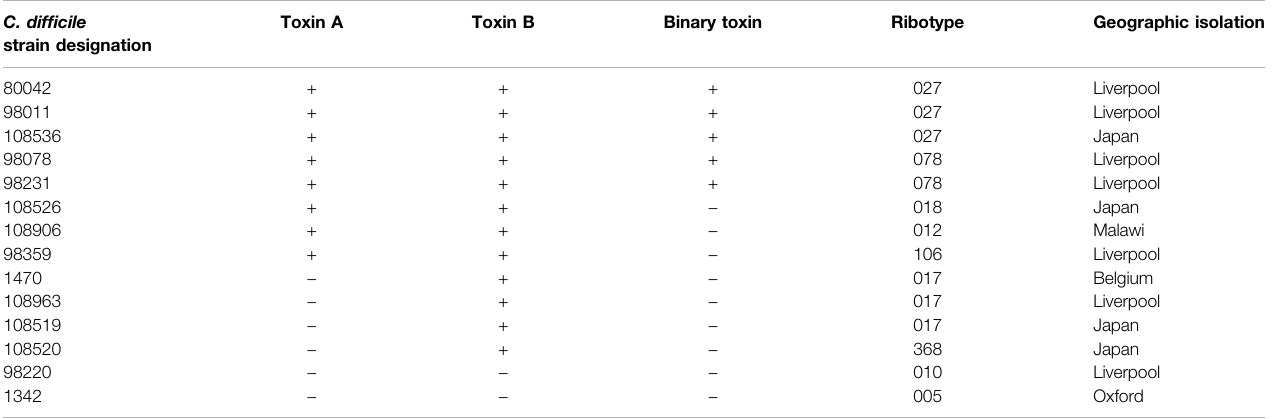
TABLE 1 | C. dif fi cile strains